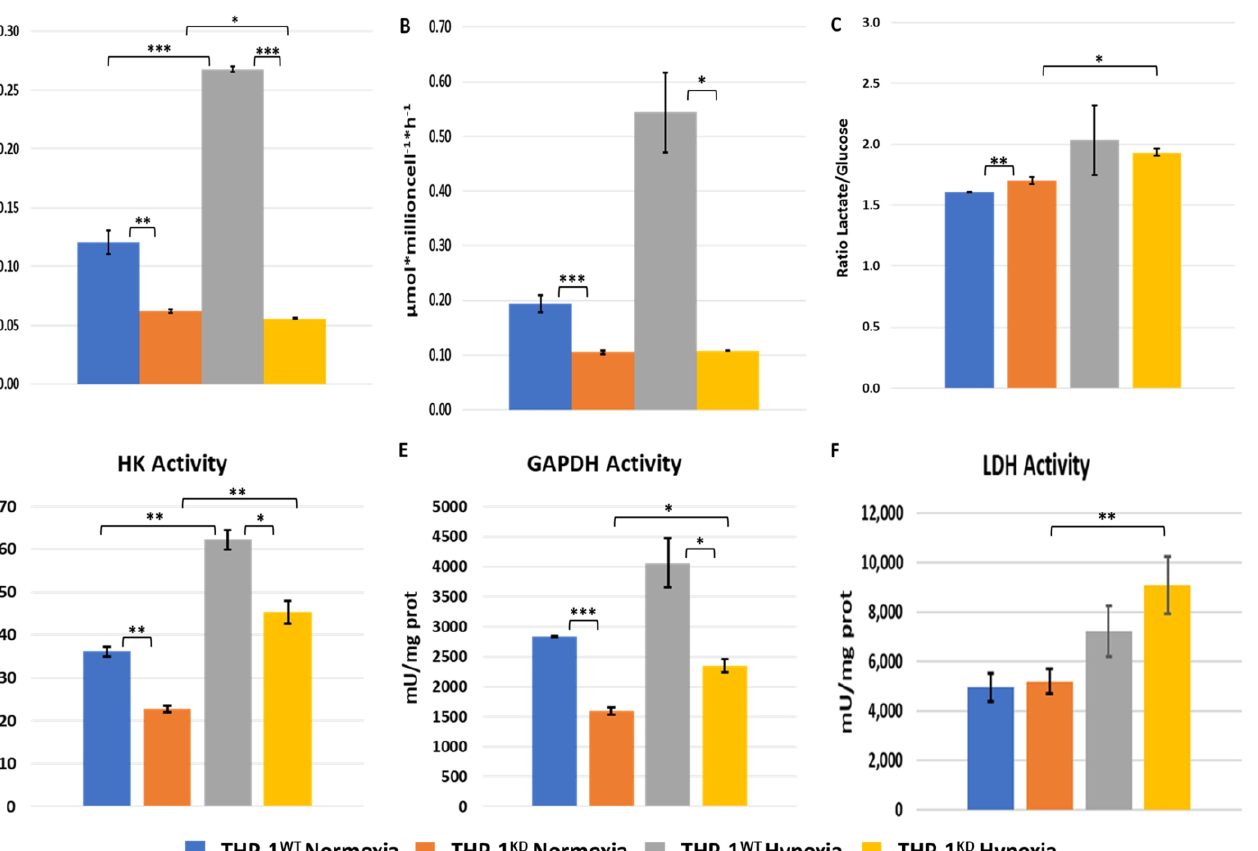
Figure 3. Loss of TKTL1 impairs hypoxia response. Changes in concentration of glucose ( A ) and lactate ( B ) in incubation medium, normalized by cell number and incubation time. Glucose and lactate concentrations were measured in incubation medium of THP-1 WT and THP-1 KD cells incu- bated for 48 h, in both normoxic and hypoxic conditions. ( C ) Ratio of change in lactate per change in glucose concentration. Enzymatic activity assays performed through spectrophotometry in normoxia and hypoxia for enzymes ( D ) hexokinase (HK), ( E ) glyceraldehyde-3-phosphate dehydrogenase (GAPDH) and ( F ) lactate dehydrogenase (LDH). Data represented are mean ± SD, with n = 3 in panels A, B and C, and n = 2 in panels D, E and F. Statistically significant differences in all panels were determined by two- tailed independent sample Student’s t -test: p < 0.05 (*). p < 0.01 (**). p < 0.001 (***).